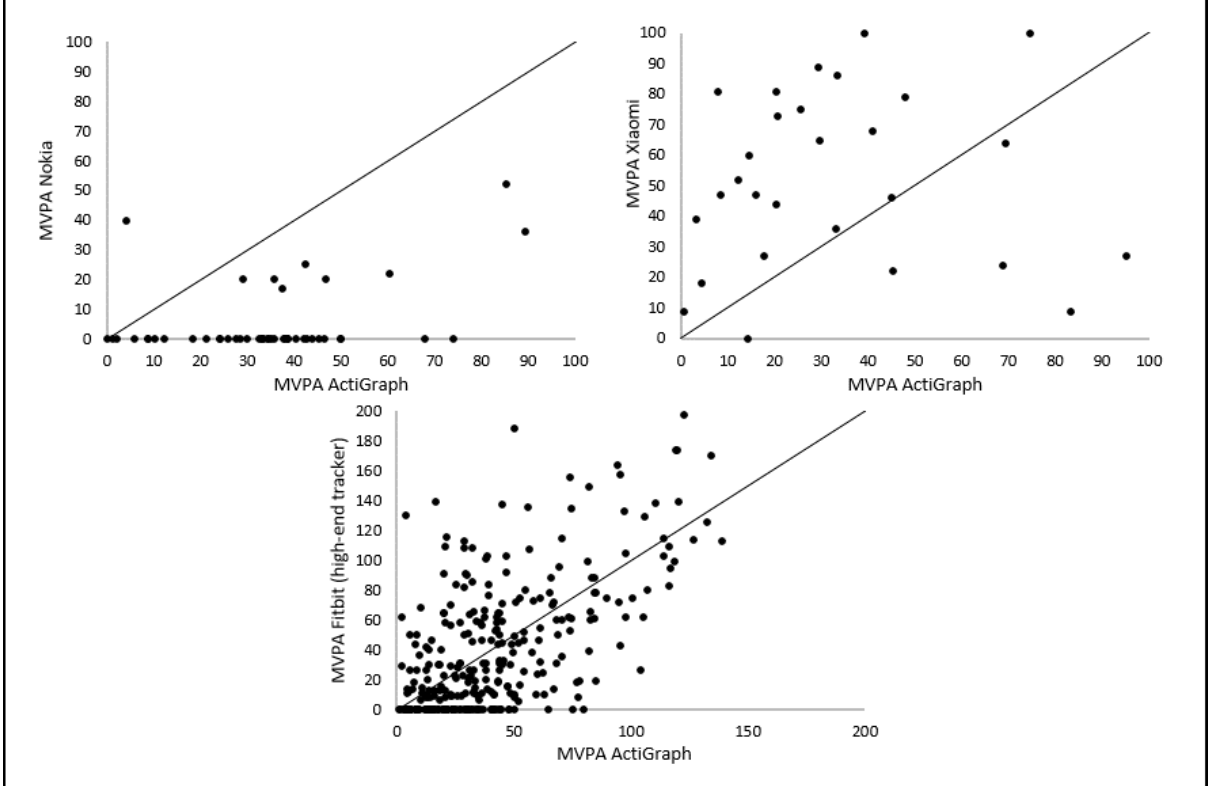
Figure 4. Correlations between moderate-to-vigorous physical activity estimates per day from the trackers and the ActiGraph.